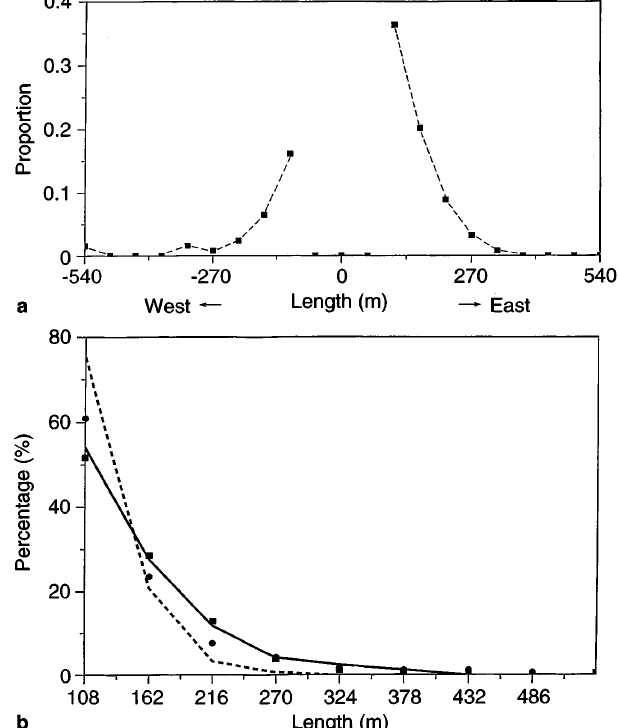
Fig. 5a, b. Frequency distribution of the length travelled by events along slope. The lengths are in multiples of 54 m, the sensor separation. a Lengths with sign taken positive for events moving to the east, negative to the west; b lengths for ( solid line ) all data, positive temperature derivatives ( squares ) and negative derivatives ( circles ). The dashed line is the distribution for data with the same duration and number of events as the real data, but occurring at random times at